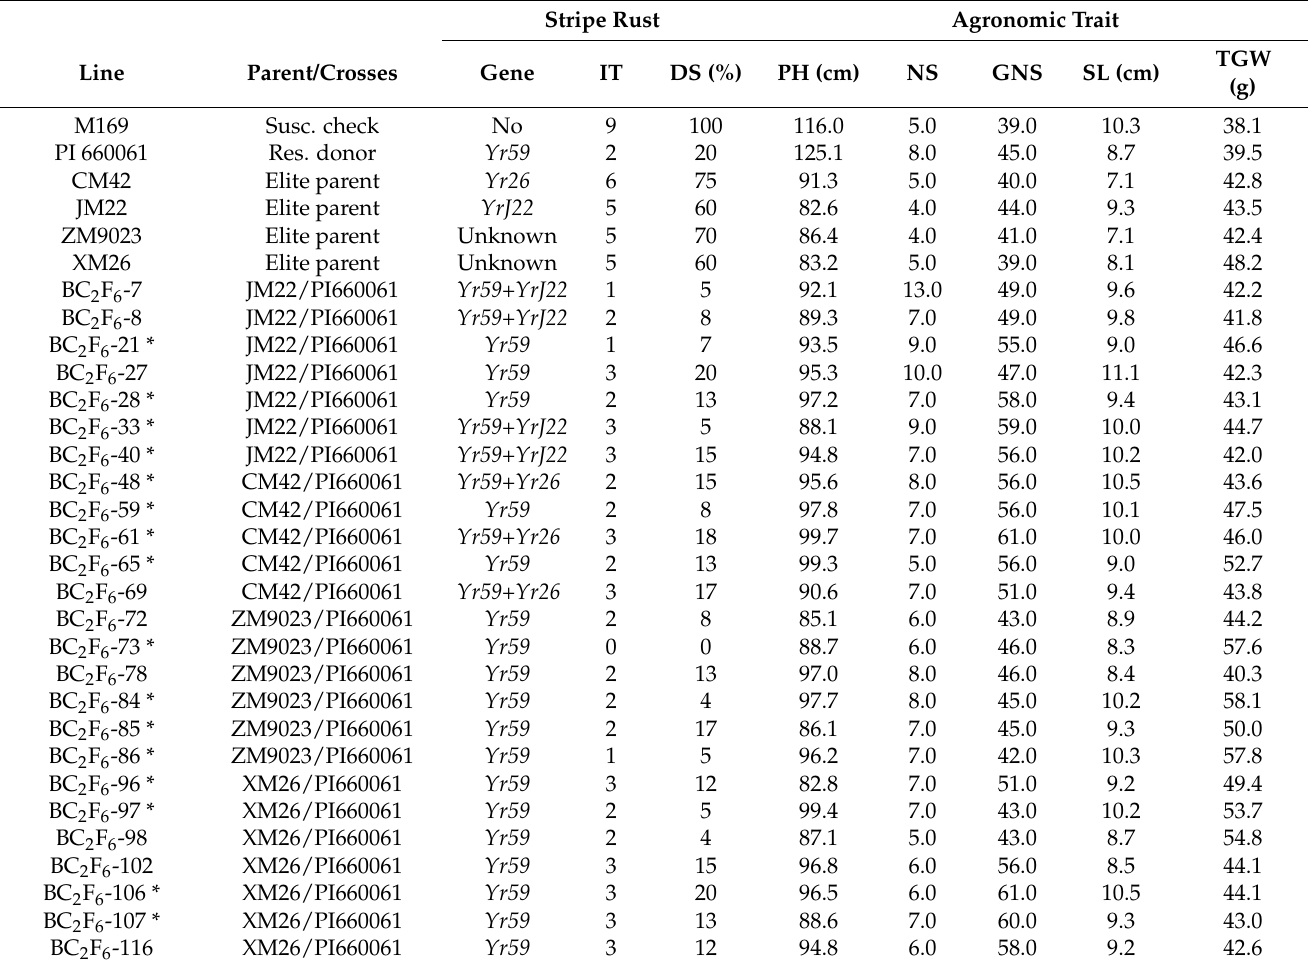
Table 4. Yr genes detected by molecular markers, infection types (IT) and disease severity (DS) of stripe rust and agronomic traits of plant height (PH), number of spikes (NS), grain number per spike (GNS), spike length (SL) and thousand-grain weight (TWG) of parents and progeny lines. Stripe Rust Agronomic